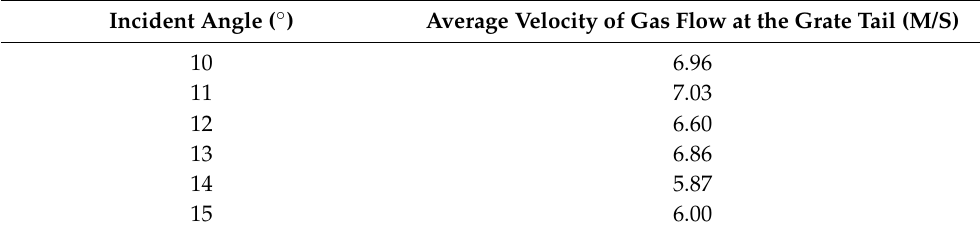
Table 6. Variation incident angle of the gas flow at the tail of the furnace under C60. Incident Angle ( ◦